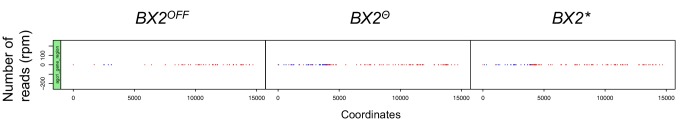
The AGO1 gene region does not produce piRNA by itself.Alignments of unique 23–29 nt reads that match the AGO1 gene region (from nucleotide 13943387 to 13958089 on the 2R chromosome) show that all genotypes produce no significant levels of piRNAs. Compare this result to that of piRNAs matching BX2 sequences (Figure 2, same y-axis scale). Positive and negative values correspond to sense (red) and antisense (blue) reads, respectively. This observation demonstrates that the AGO1 gene region is not a natural piRNA producing locus.